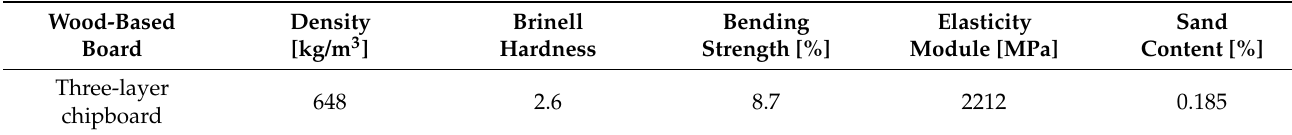
Figure 4. Three-layer chipboard. Table 1. Selected properties of the tested three-layer